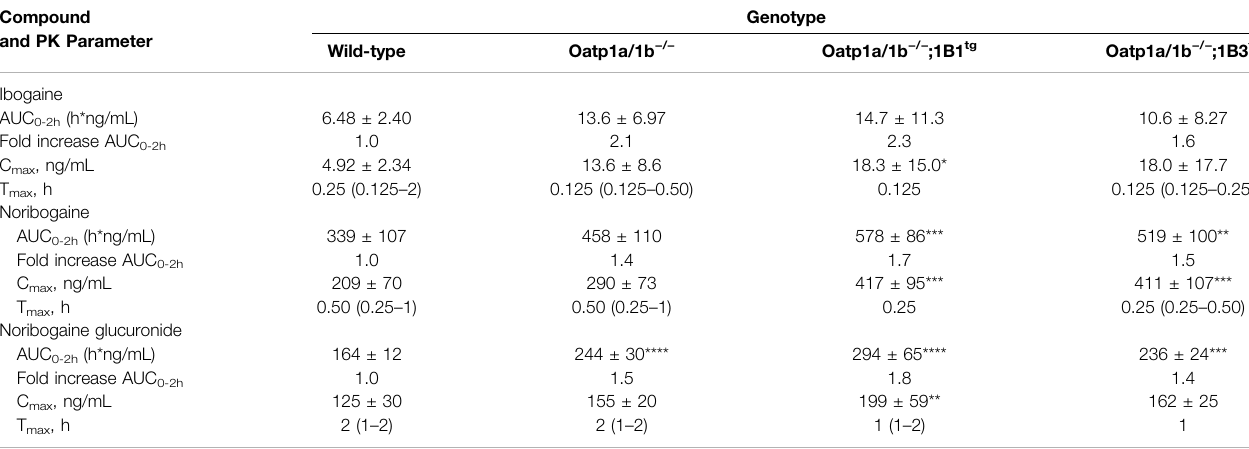
TABLE2| Plasmapharmacokinetic(PK)parametersofibogaine,noribogaine,andnoribogaineglucuronide2 hafteroraladministrationof10 mg/kgibogainetofemalewild- type, Oatp1a/1b − / − , Oatp1a/1b − / − ;1B1 tg , and Oatp1a/1b − / − ;1B3 tg mice a